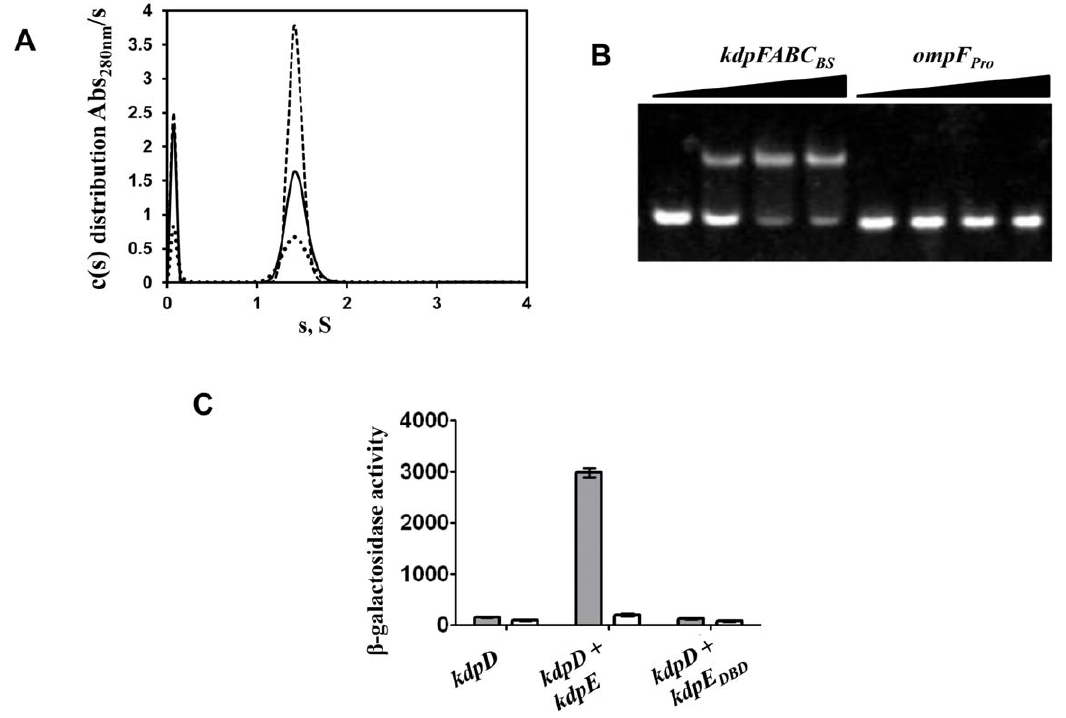
Figure 1. Biochemical and functional characterization of KdpE DBD . A. Sedimentation velocity analysis of the KdpE DBD to detect self- association. The c(s) distribution of the KdpE DBD at 21 (dots), 42 (solid line), and 84 m M (dashes) shows a single species of 1.4 S. No concentration- dependent formation of higher-order species was observed. B. Interaction of KdpE DBD protein with kdpFABC BS and ompF Pro DNA sequences analyzed by EMSA. The triangles represent increasing molar ratios of 1:0, 1:1, 1:2, and 1:3 of DNA to purified KdpE DBD . The lower and upper bands represent free DNA and DNA-KdpE DBD complex, respectively. C. In vivo analysis of expression of the b -galactosidase gene fused to kdpFABC Pro . E. coli RH003 cells lacking the histidine kinase ( kdpD ) and RR ( kdpE ) were used to express full-length KdpD alone as well as KdpD combined with KdpE or KdpE DBD . As described in the methods, the cells were grown in K0 ( & ) and K10 ( % ) media prior to analysis of gene expression. Growth in K0 medium mimics stresses resulting from external K + depletion. The b -galactosidase activity expressed as Miller units represents the mean of three independent experiments; error bars represent standard error.